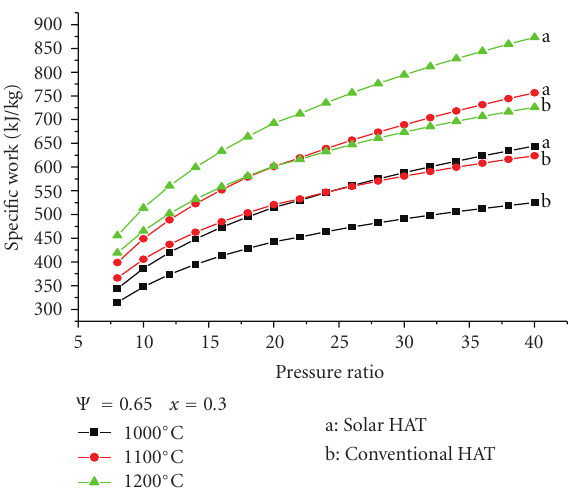
Figure 3: Variation of specific work with pressure ratio.